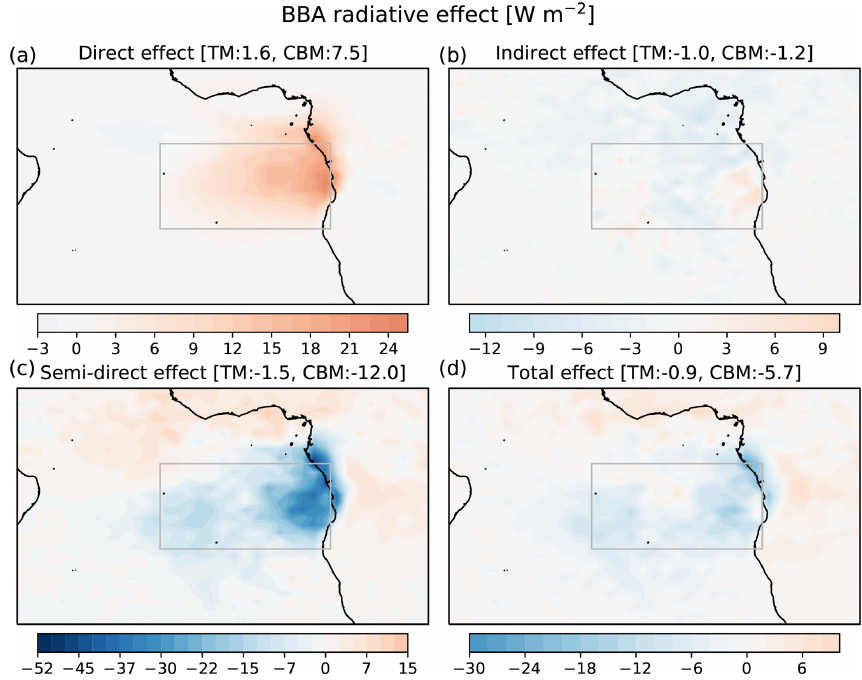
Figure 9. UKESM1 mean net (shortwave + longwave) biomass burning aerosols. (a) Direct, (b) indirect, (c) semi-direct, and (d) total radiative effects during July and August 2016–2017. The same colour map scale is used for each plot, but the colour map ranges differ in each plot, corresponding to the maximum and minimum of the effect in